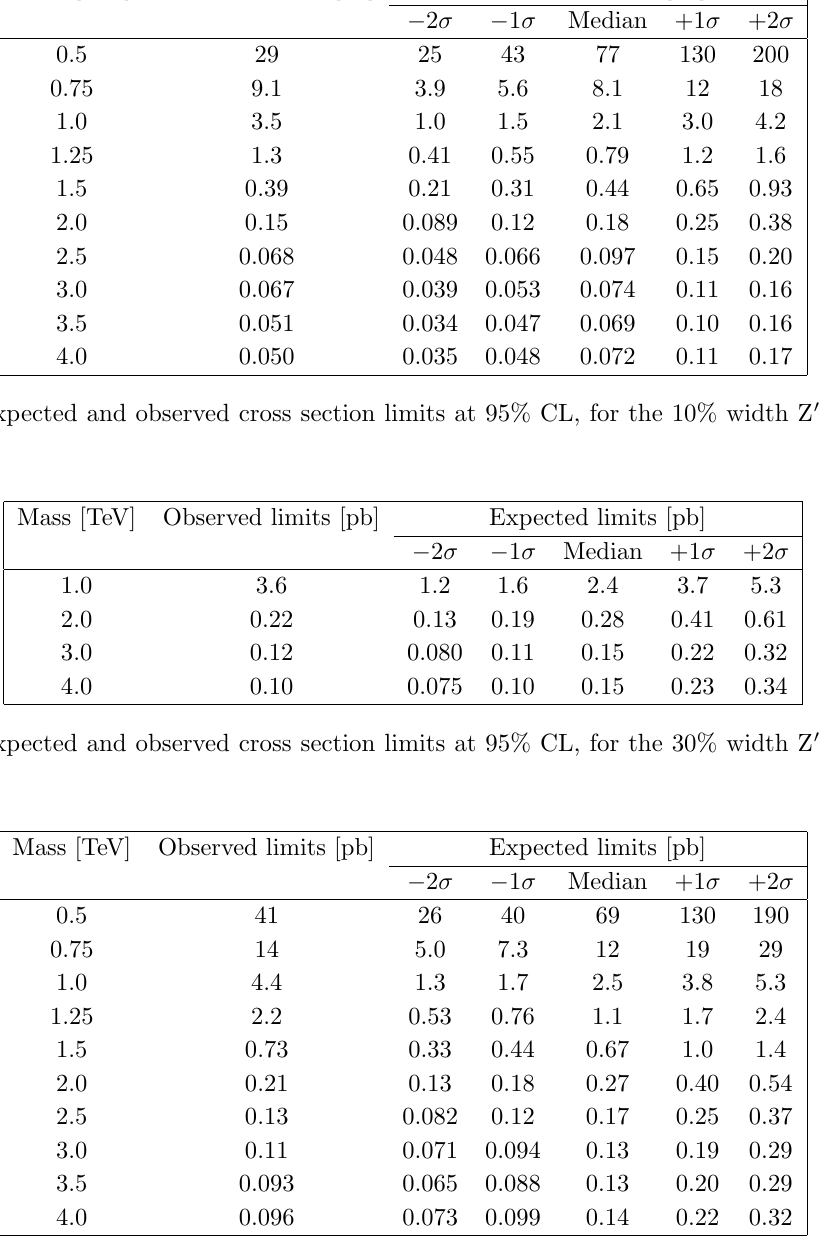
1 TeV, where (cid:12)nal-state decay products become collimated because of the large Lorentz boosts of the top quarks. The analysis method provides an in-situ measurement of the data-to-simulation scale factor for the t tagging e(cid:14)ciency and the normalization of the main backgrounds. No evidence for massive resonances that decay to tt is found. Limits at 95% CL are set on the production cross section of new spin-1 particles decaying to tt with relative decay widths that are either narrow or wide compared with the detector